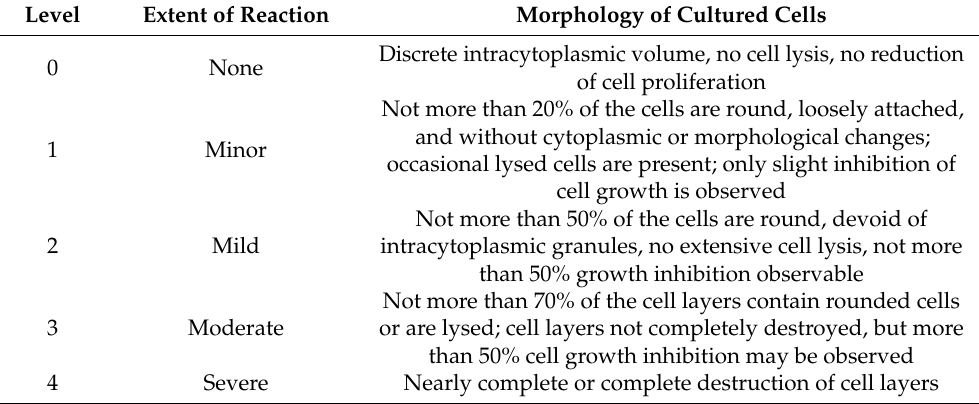
Figure 8. Microscopic view of in vitro cytotoxicity. The morphology of the HUVECs in the stent and polyethylene indicates that the cells were normal. HUVECs in the polyurethane group started to be lysed from 24 h. Table 4. Qualitative morphological grading of cytotoxicity of extract [35] .